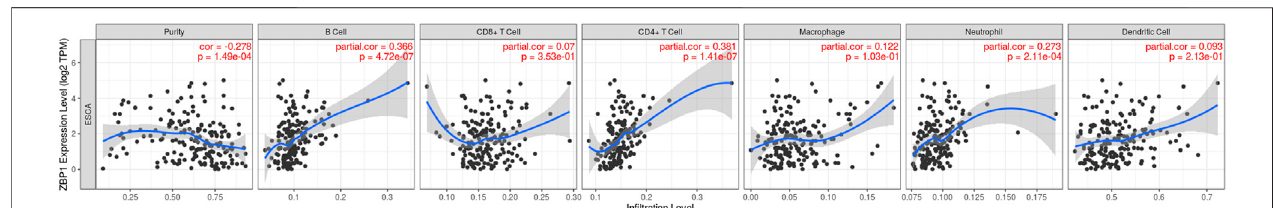
FIGURE 8 | Correlations between immune cells and selected genes. ZBP1 and immune cells in esophageal cancer.